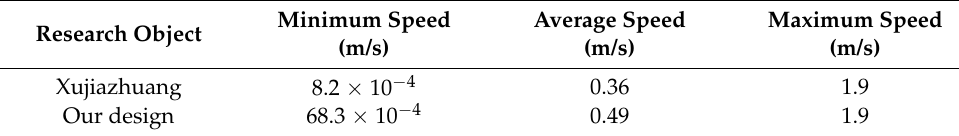
Figure 10. Wind speed distributions in Xujiazhuang and our design. Table 2. Statistics of wind speed in Xujiazhuang and our design.